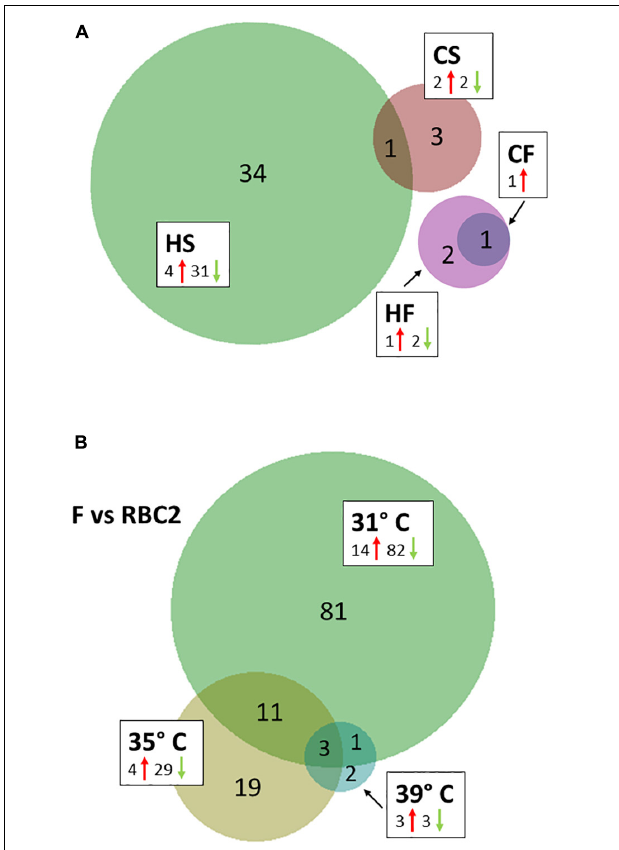
FIGURE 2 | (A) Venn diagram of significant differentially expressed circRNAs (DEC) shared between temperature comparisons. HS, heat-treated slower growing (RBC2); CS, cold-treated slower growing; HF, heat-treated, faster growing (F-line); and CF, cold-treated, faster growing. (B) Distribution of significant differentially expressed circRNAs (DECs) in between-line